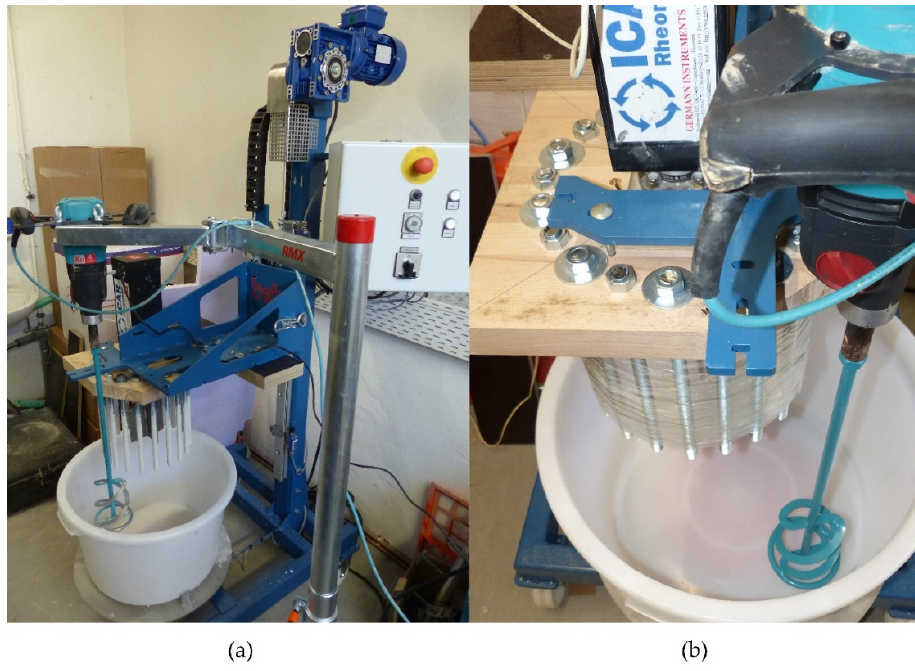
Figure 2. ( a ) Experimental setup for the ICAR rheometer; ( b ) the threaded rods were wrapped from the outside with several layers of adhesive tape for TEST 1.